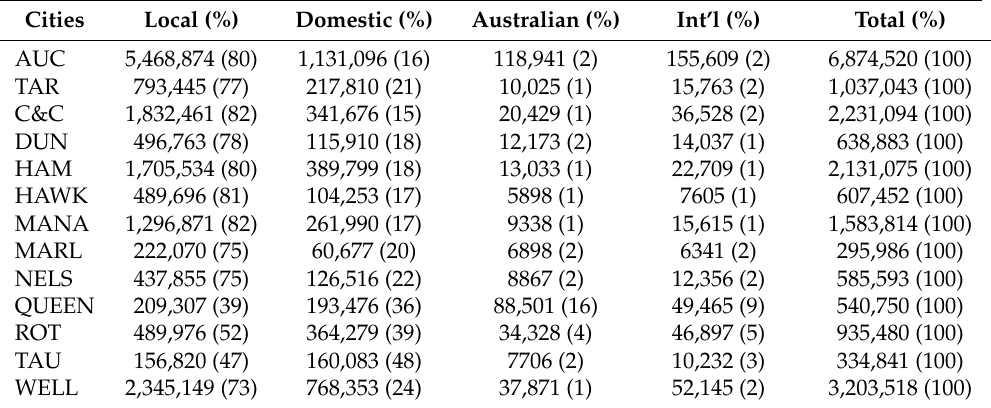
Table A3. Total volume by delegate origin dimension for eight years